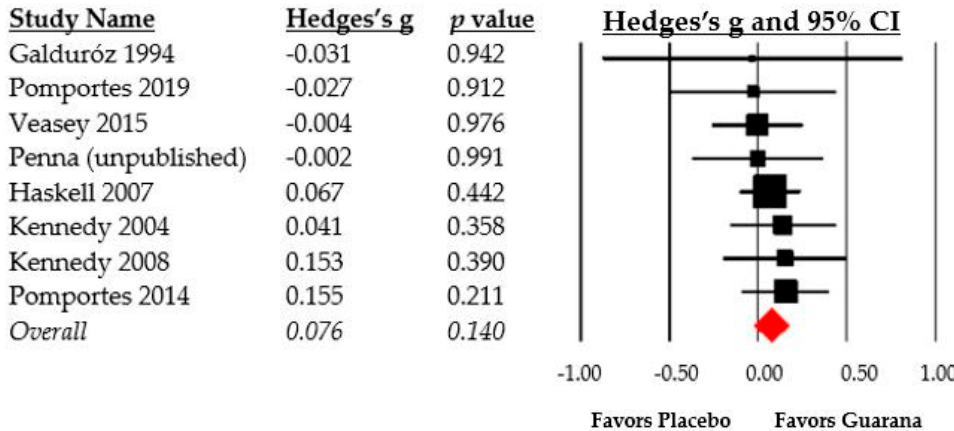
Figure 2. Forest plot of effect sizes from eight studies averaged across all outcomes (multiple doses, accuracy, and response time for several cognitive tests). Squares represent the effects size and its size proportional to the study weighting in the meta-analysis. Horizontal lines indicate 95% confidence intervals. The red diamond width indicates a 95% CI for the overall effect size.